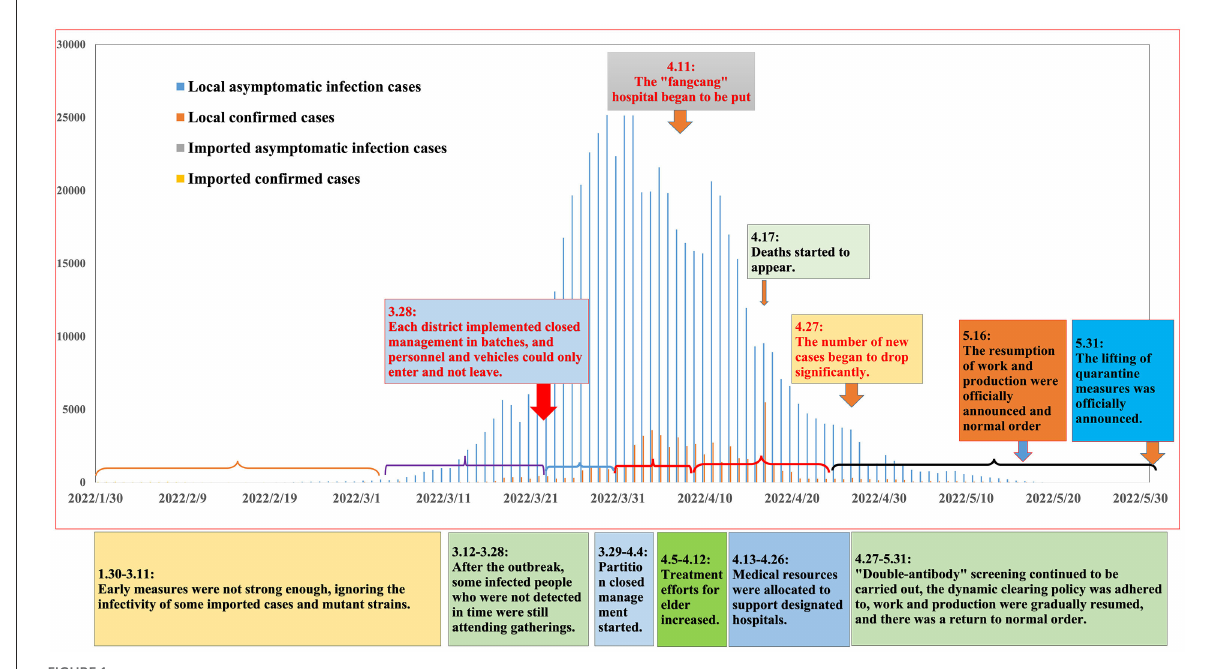
FIGURE1 Correlation analysis between daily cases and public health intervention. Based on the date of symptoms, the epidemic curve shows the number of cases and events per day. We also further describe the key events, situation characteristics and details of public health interventions at each